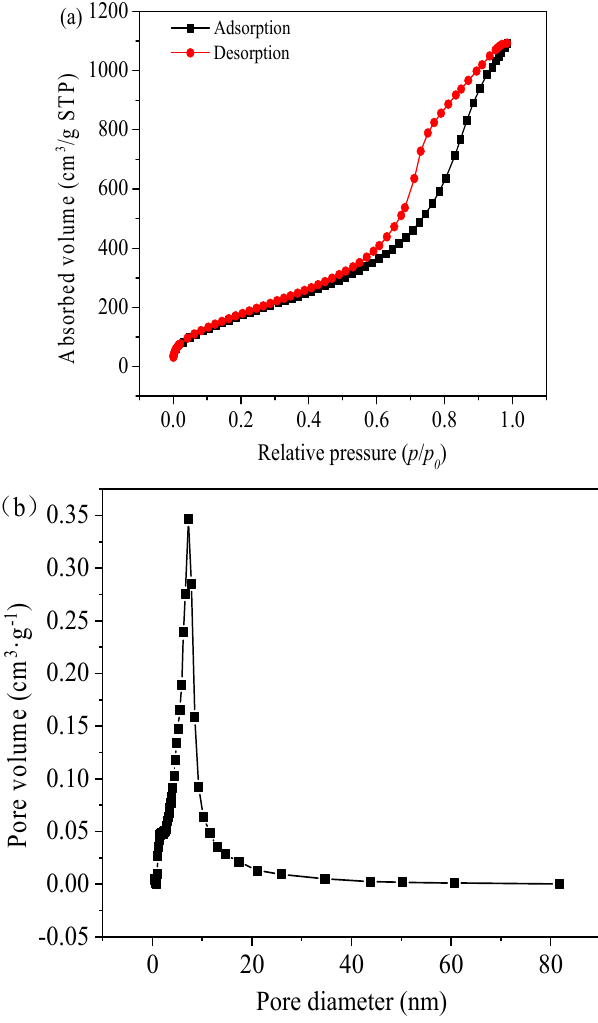
Figure 6. N 2 adsorption-desorption of the silica aerogel powders: ( a ) BET isotherm; ( b ) BJH pore size distribution (PSD) derived from desorption branch.